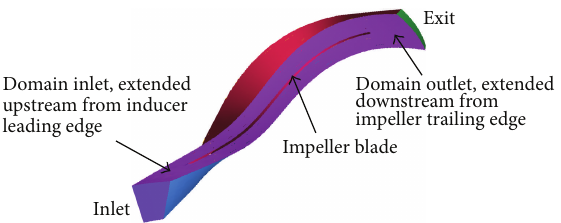
Figure 5: Computational domain of baseline impeller with one blade passage and inlet and exit domain extensions.